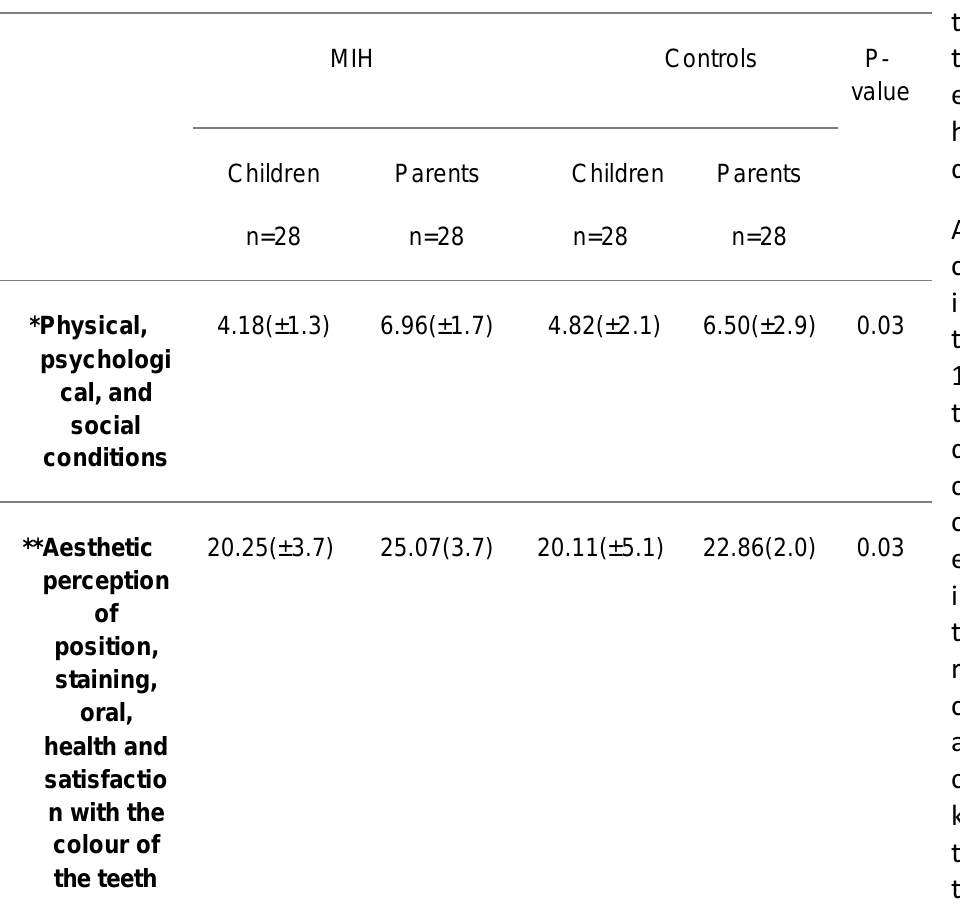
TABLE 3. Comparison of aesthetic perceptions between children and parents with MIH and